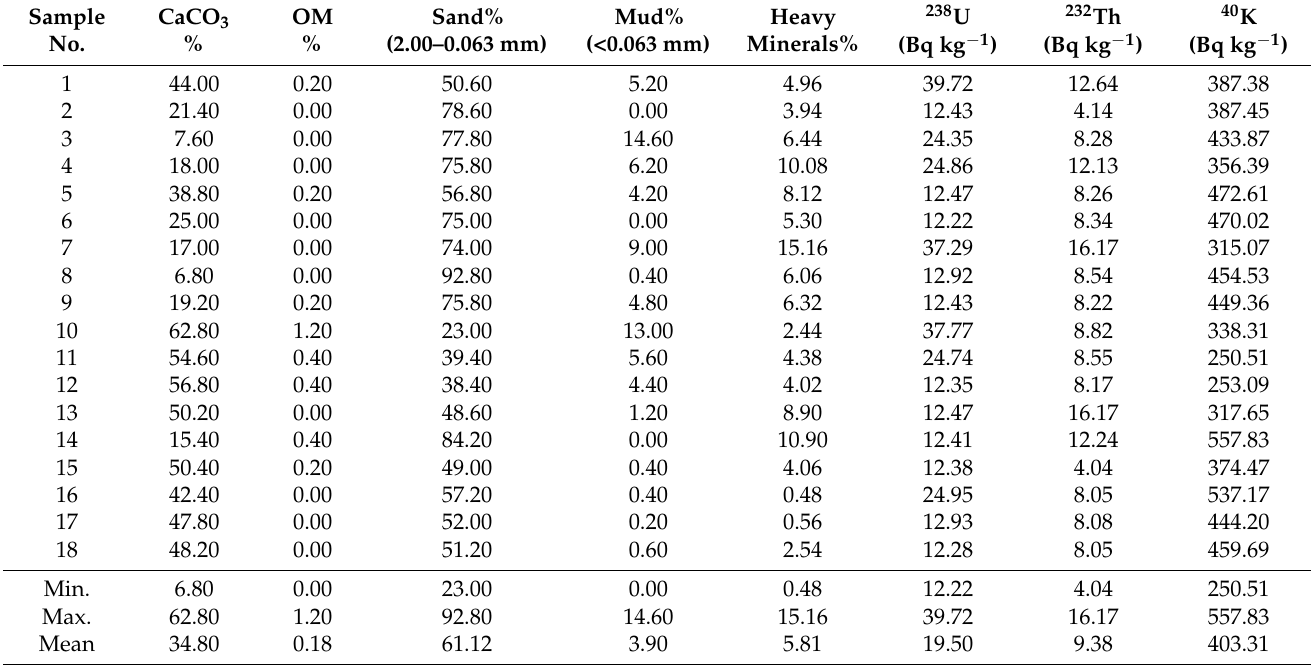
Table 1. Grain size data, heavy minerals index, and activity concentration of the measured